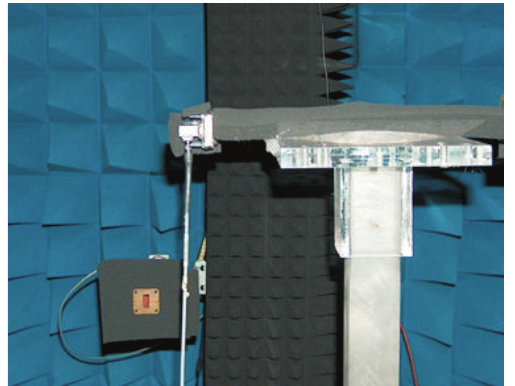
Figure 6: Photograph of measuring probe into anechoic chamber at the University of Calabria.